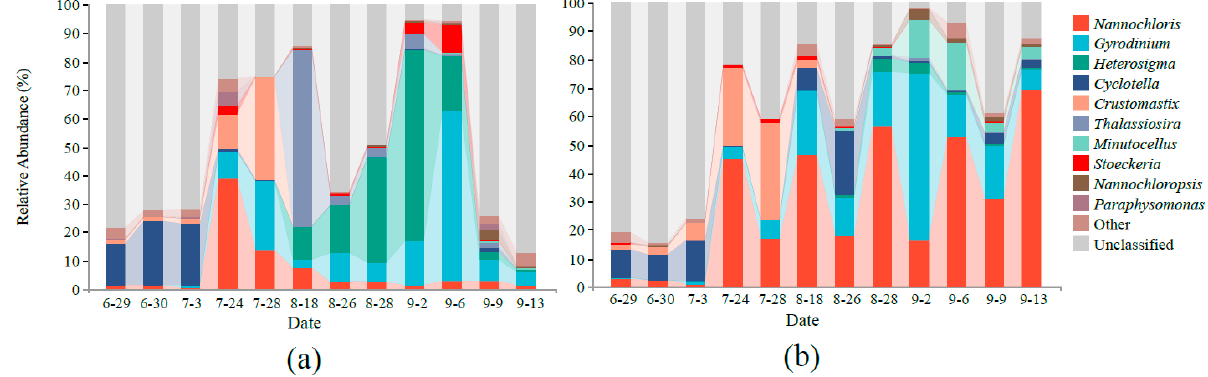
Figure 3. The relative abundance of the ten most abundant phytoplankton genera varied among treatments: ( a ) control pond, ( b ) MC-treated pond.